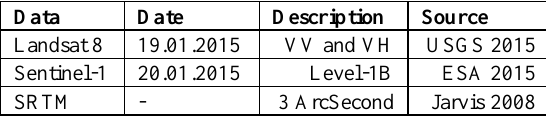
Table 1. Data sets